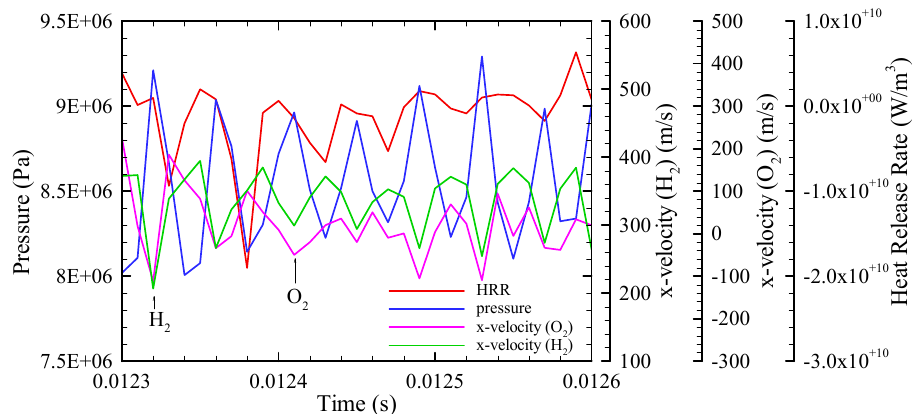
Figure 15. Plot of the pressure, x -velocity of oxygen, and x -velocity of hydrogen, and heat release rate comparison according to the phase change during multiple periods of the cycles at the injector exit. Energies 2021 , 14 , x FOR PEER REVIEW